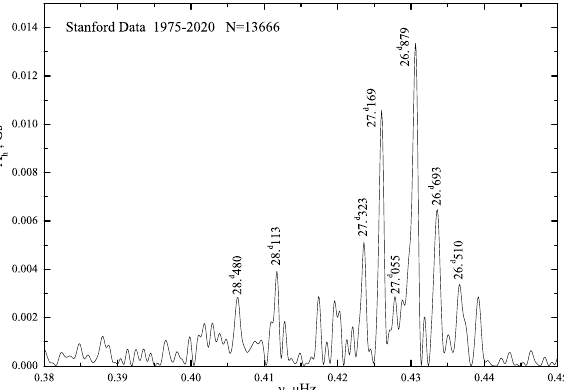
Figure 2. Power spectrum of the MMF in the region of the solar rota- tion periods. The ordinate is the square of the harmonic oscillation amplitude in Gs 2